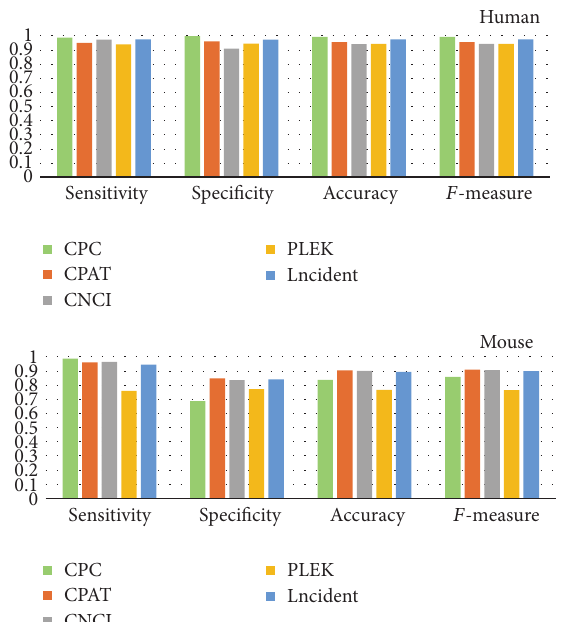
Figure 4: The performances of different tools on different species.